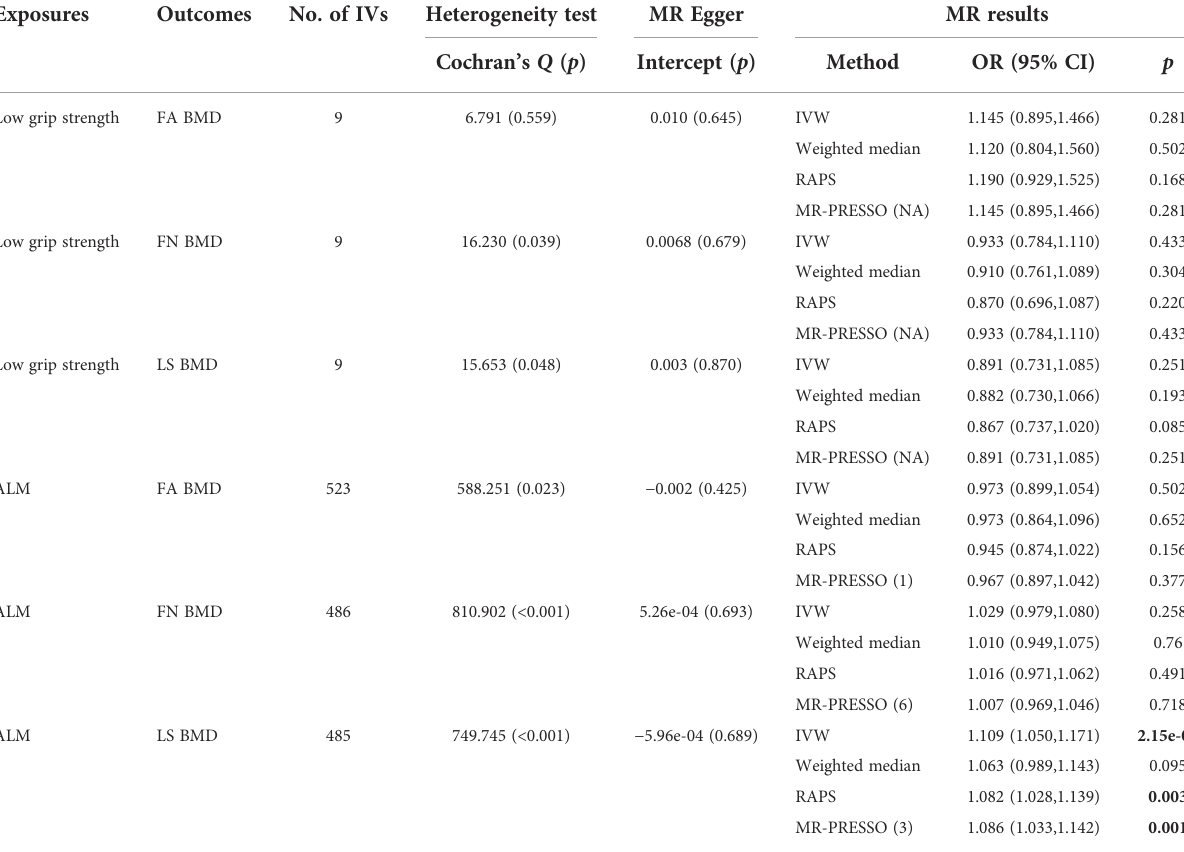
Numbers in parentheses depict outlier IVs number (Supplementary Table 3). Bonferroni-corrected signi fi cance level (0.05/(2×3) = 0.008) was used to correct for multiple comparisons. p < 0.008. The bold values meant that the p < 0.008. BMD, bone mineral density; ALM, appendicular lean mass; FA, forearm; FN, femoral neck; LS, lumbar spine; MR, mendelian randomization; IVs, instrumental variables; CI, con fi dence interval; OR, odds ratio; IVW, inverse variance weighted; MR-PRESSO, Mendelian Randomization Pleiotropy RESidual Sum and Outlier; MR-RAPS, Mendelian Randomization Robust Adjusted Pro fi le